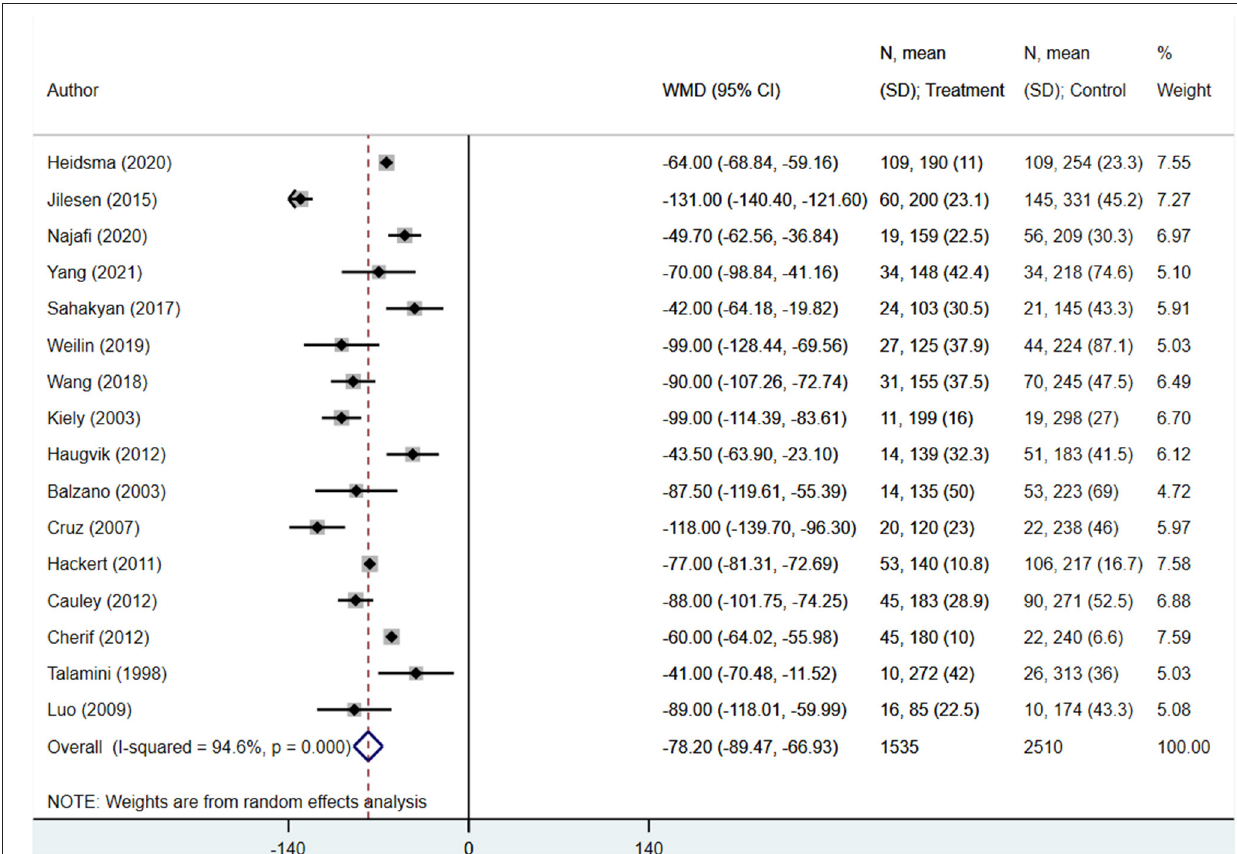
FIGURE 2 | Comparison of operation time (in minutes) between enucleation and standard surgical resection.